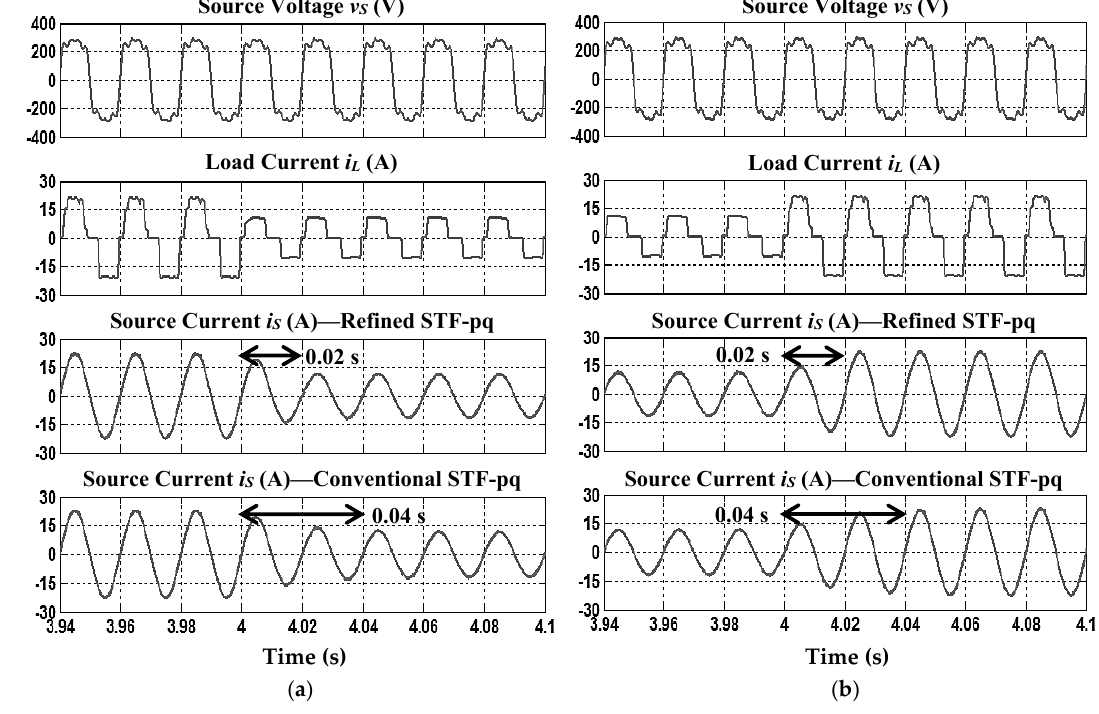
Figure 6. Phase A simulation waveforms (case 2) which include source voltage v S , load current i L , source current i S resulted from refined STF-pq theory algorithm, and source current i S resulted from conventional STF-pq theory algorithm for dynamic-state conditions of ( a ) resistive to inductive and ( b ) inductive to resistive.